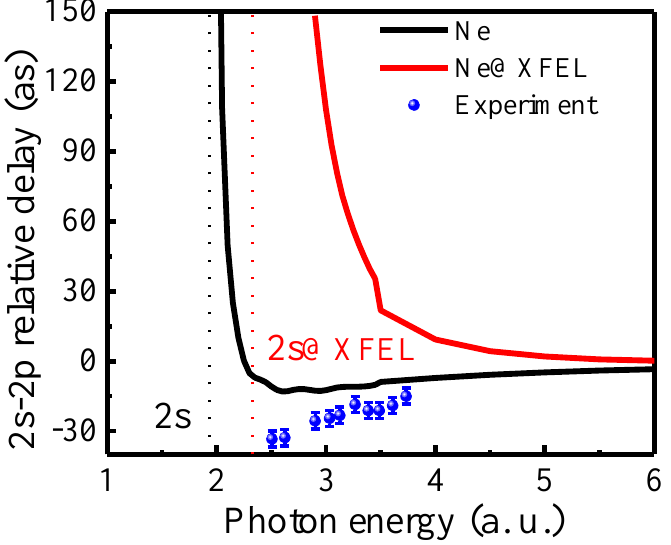
Figure 6. The time delay difference of 2s and 2p subshell (τ(2s)-τ(2p)) of Ne (black) and Ne@XFEL (red) in the RRPA calculation is compared with that from the experiment (blue) [47]. Vertical lines show the 2s subshell threshold for Ne (black) and Ne@XFEl (red).